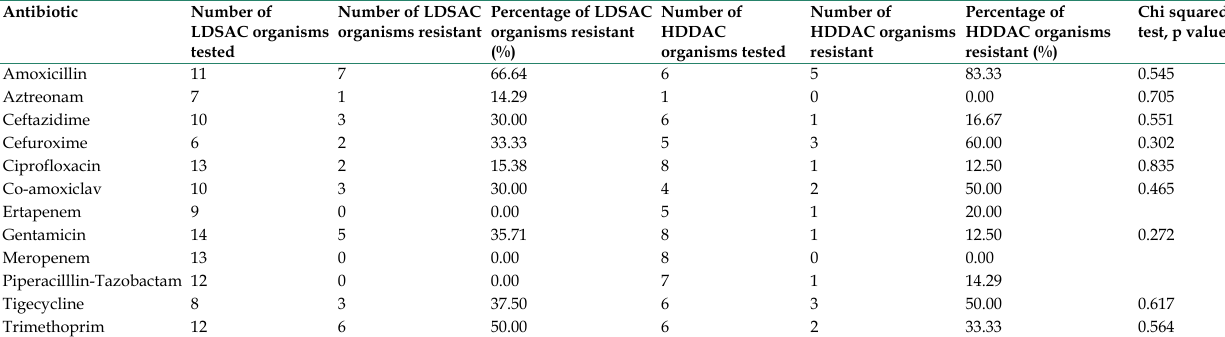
Table 3. Resistance rates in Gram negative organisms